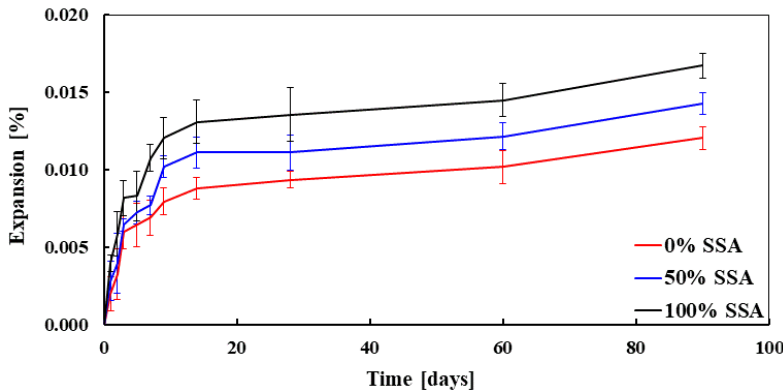
Figure 5. Longitudinal expansion of concrete mixes as a function of time.